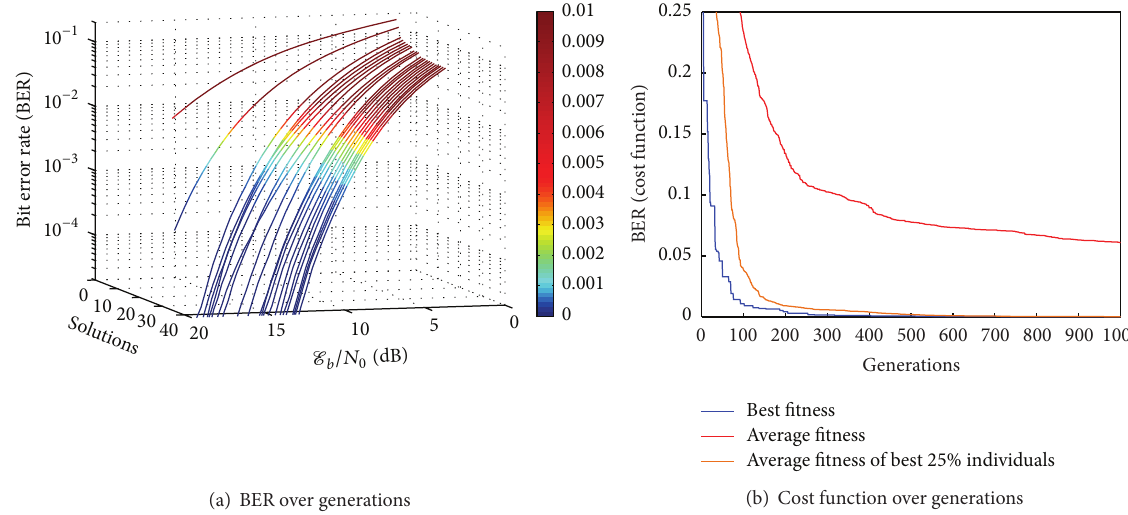
Figure 8: (a) BER of the best solutions found by the DE iteratively. (b) Cost function over iterations for a single optimisation run. The average cost is computed out of the whole population.